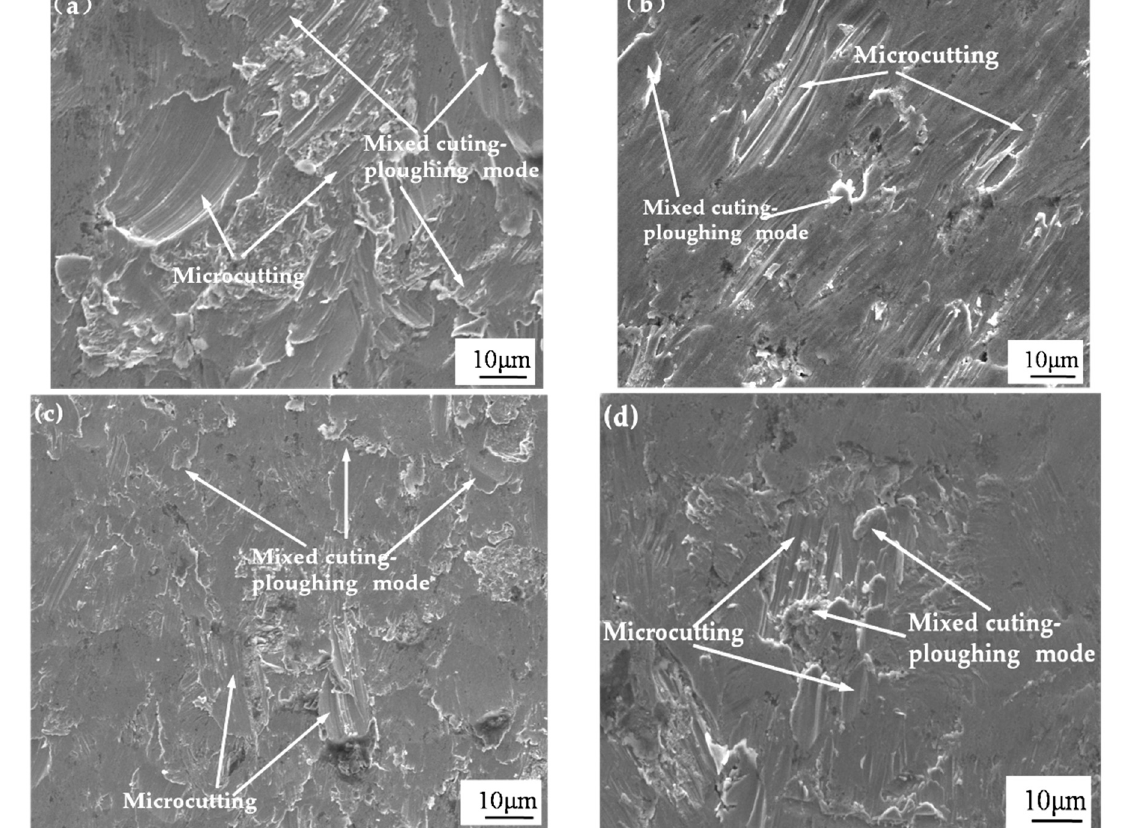
Figure 9. The eroded surface SEM micrographs of Al x CoCrFeNiTi 0.5 HEA coatings after 30-min slurry erosion: ( a ) Al 1.0 ; ( b ) Al 1.5 ; ( c ) Al 2.0 ; and ( d ) Al 2.5 at 10.08 m/s, 1.0 wt. % sand concentration and 45° impingement angle.